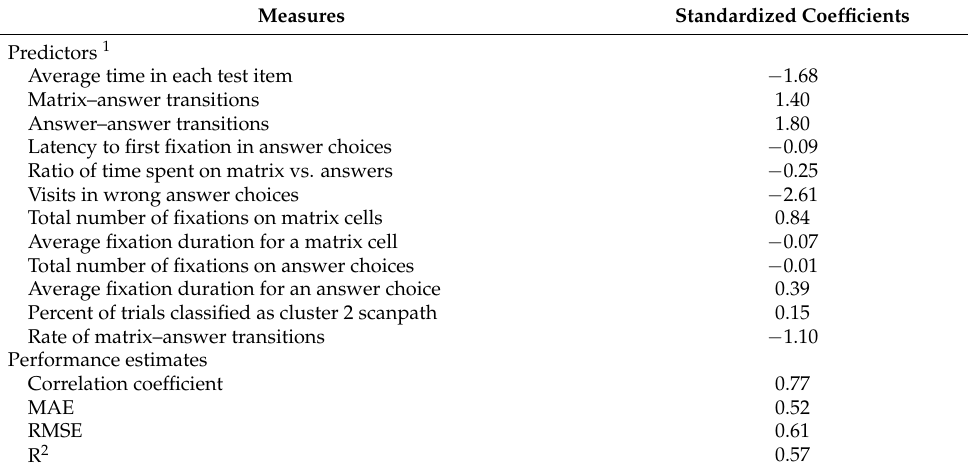
Table 3. Coefficients and measures of the LASSO regression model predicting the D.70 total